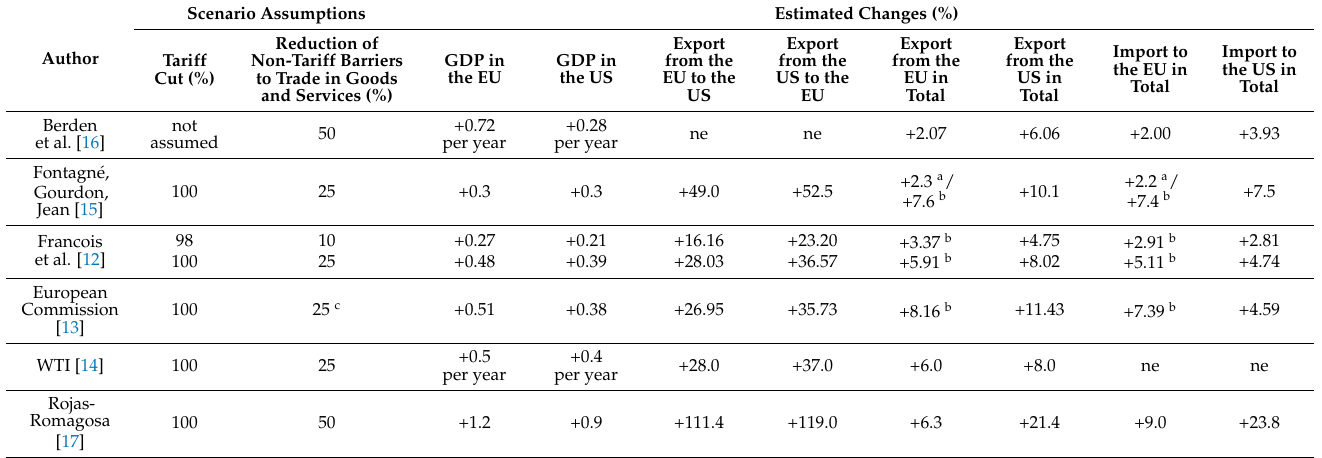
Table 1. Estimated macroeconomic impacts of the TTIP on the EU and the US economies (changes in % compared to status